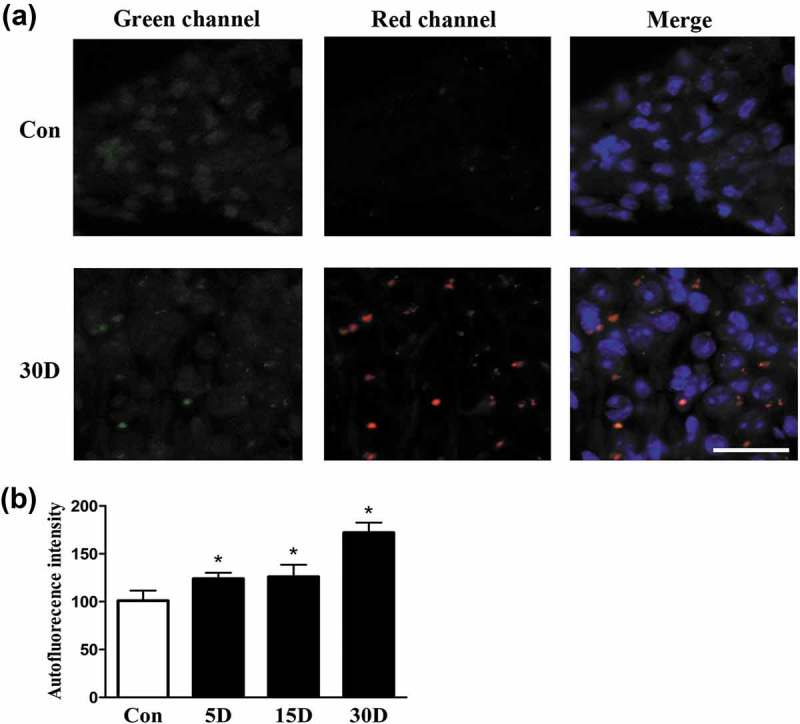
Lipofuscin autofluorescence was increased during SGN degeneration in the cochleae of mice. (a) Lipofuscin autofluorescence within SGNs taken from the middle turn of cochlea in the blank control (Con) and experimental mice on the 30th day after ototoxic drug administration, as observed under a confocal microscope. Lipofuscin-like granules are represented as yellow dots in the merged panel. (b) Lipofuscin autofluorescence intensity within SGNs at each observation point. *, compared with that in the blank control group, the autofluorescence intensity in the degenerated SGNs was statistically increased (P < 0.05).; con normal mice without drug treatment; 30D, 30 days after drug administration. Scale bar: 50 µm.